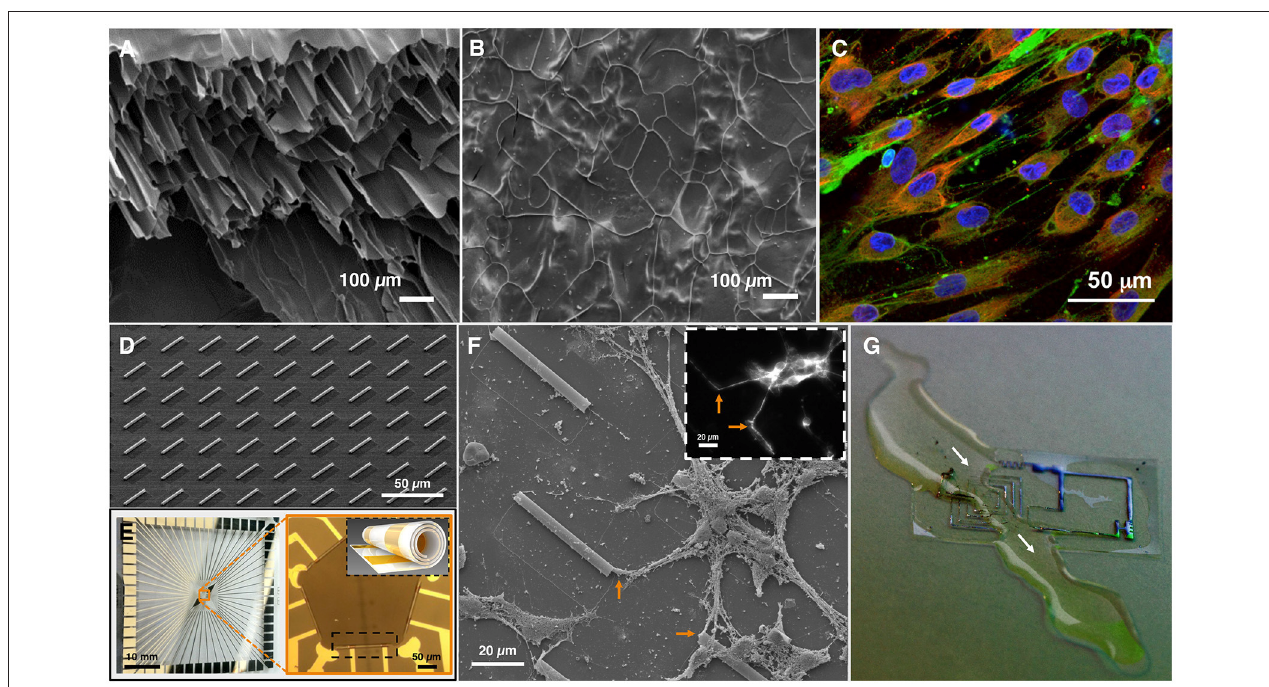
FIGURE 1 | Material applications of topography, electrical stimulation, and stiffness. (A) Scanning electron micrograph (SEM) of fractured hydrogels reveals the internal structure of the hydrogel with microchannels, or (B) micropores (images A,B adapted from Lee et al., 2015a). (C) Human bone marrow stromal cells (hBMSCs) cultured on hydrogel with aligned microchannels differentiate into a neuronal phenotype. Fluorescence imaging reveals MAP2 (neuronal marker, green), GFAP (glial marker, red), and DAPI (nuclear marker, blue) immunoreactivity, demonstrating differentiation of hBMSCs into cells expressing neuronal or glial markers, and elongating in the microchanneled hydrogel (image contributed by H. J. Kong, University of Illinois at Urbana-Champaign). (D) SEM of array of self-rolled-up membranes (S-RuMs) composed of thin-film silicon nitride bilayers. (E) A multi-electrode array chip (left) with S-RuMs patterned in a pentagon formation (orange box, right). Black inset shows schematic of single S-RuM with gold electrodes rolled inside (images D,E contributed by X. Li, University of Illinois at Urbana-Champaign). (F) SEM of rat hippocampal neurons cultured on S-RuM substrate (3 days in vitro ). Inset: Fluorescence imaging reveals MAP2 (neuronal marker, white) immunoreactivity, confirming neuronal cell type. Orange arrows correspond to entry of neurites into S-RuMs. (G) An example of flexible, biocompatible, dissolvable electronics: an electronic circuit dissolving in a stream of water. White arrows indicate the path of the water and the region of the circuit that is dissolving (image contributed by J.A. Rogers, Northwestern